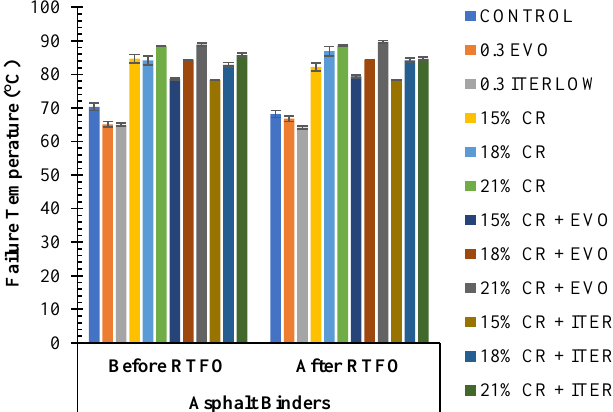
Figure 11. Calculated failure temperatures for the modified and unmodified samples.